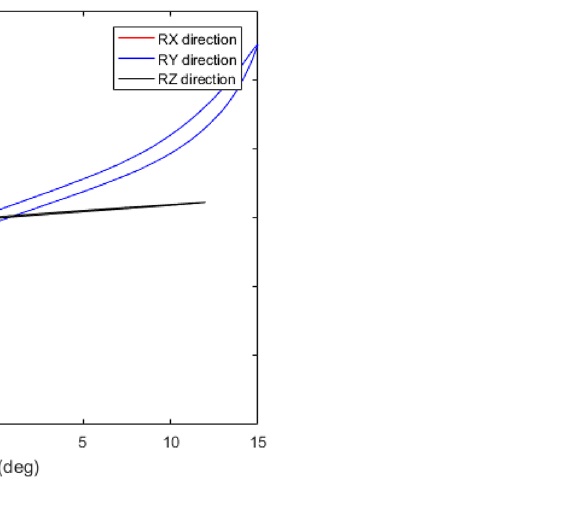
Figure 3. Torsional stiffness in x/y/z